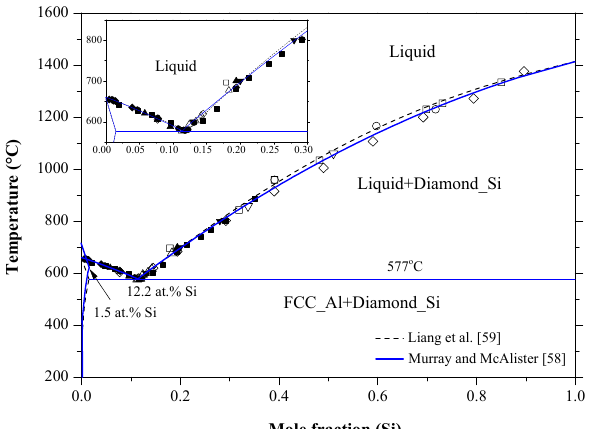
Figure 3. The Al-Si phase diagram redrawn after [58]; -----: [59]; + : [65]; ○ : [76]; □ : [77]; Δ : [78]; : [79];